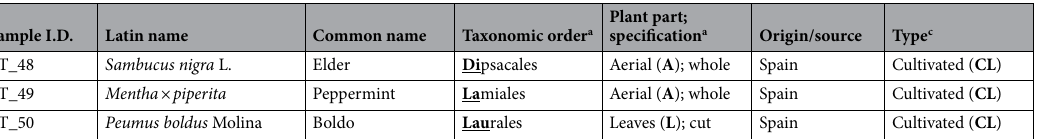
Table 1. List of botanical samples ( n = 30 species) analysed in this study. The selected plants analysed in this study are currently under investigation in the Department of Biological Sciences at MTU for various medicinal, culinary and agricultural functionalities. a Taxonomic order, plant part(s) and type(s) categories are underlined in bold for use as labels in PCA figures (“Principle component analysis (PCA)” section). b Specification refers to the level of processing of the final product. c Certified organic plant